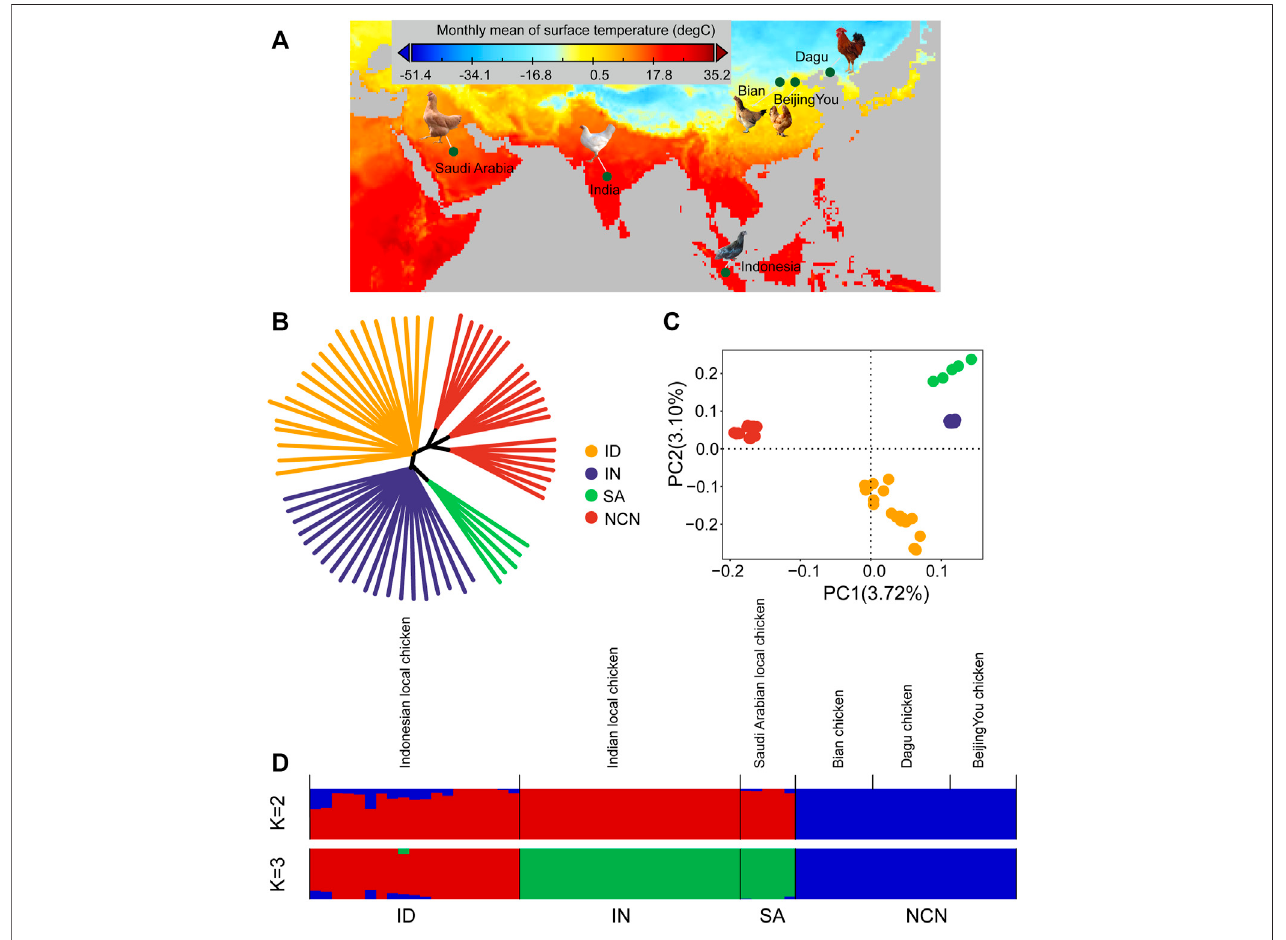
FIGURE 1 | Population structure and relationships of tropical chickens. (A) geographic variation of monthly mean surface temperature for the location of chickens used in the study. (B) neighbor-joining tree. (C) principal componentanalysis (PCA) with the fi rst (PC1) and second (PC2) principalcomponents. (D) genetic structure of all chicken groups using ADMIXTURE program with K = 2 and K = 3. Indonesian chickens (ID), Indian chickens (IN), Saudi Arabian chickens (SA), and chickens of northern China